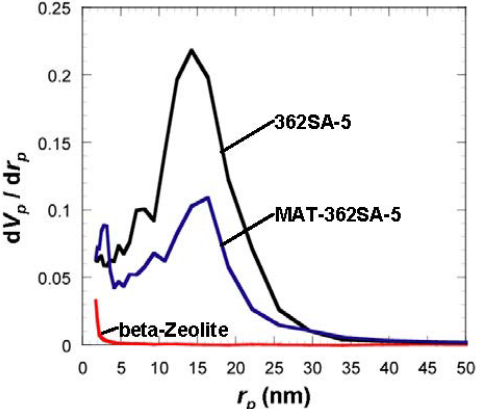
Figure 6. Comparison of BJH pore-size distribution for silica-alumina, mixed catalyst and zeolite. r : pore p